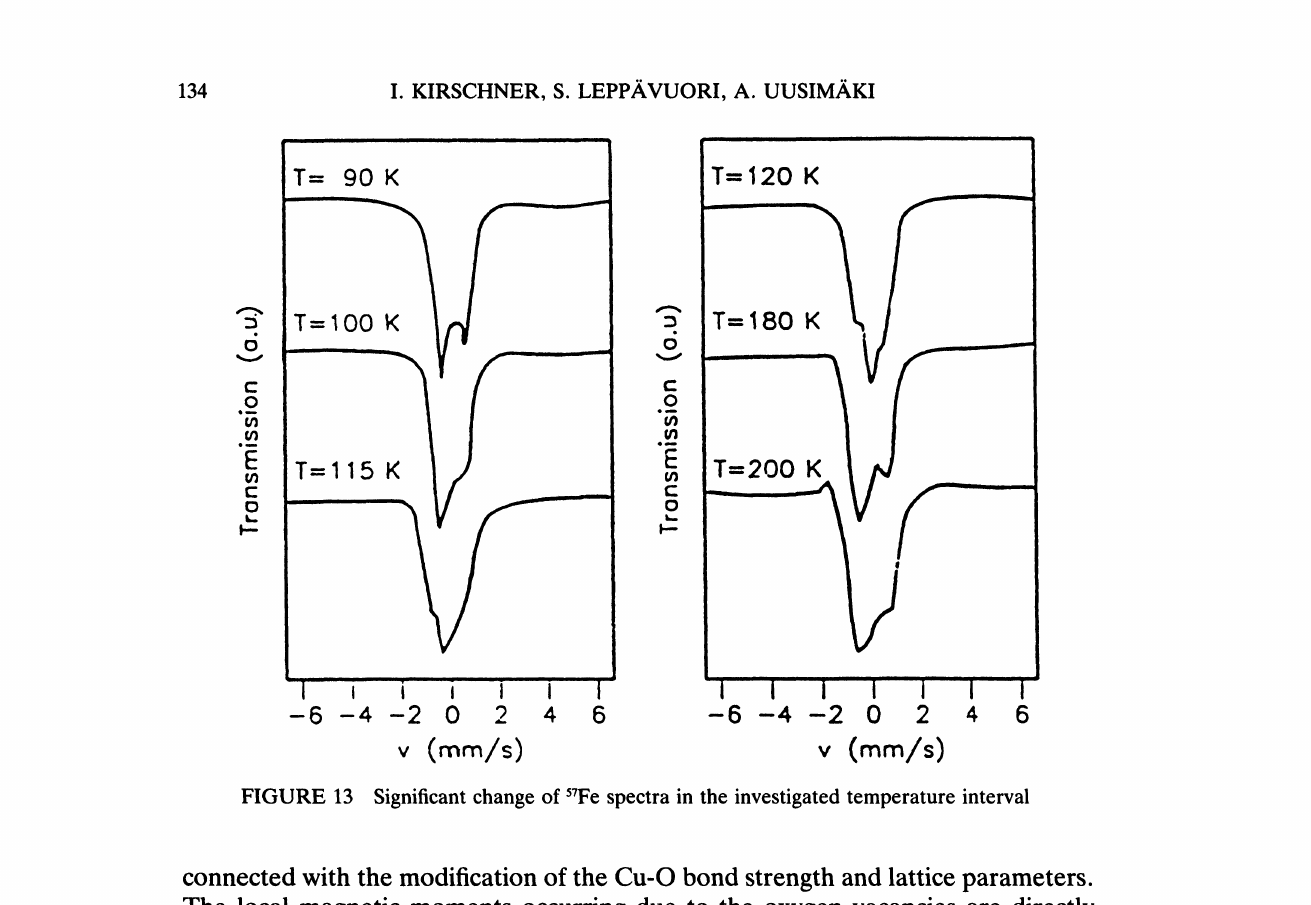
FIGURE 13 Significant change of 7Fe spectra in the investigated temperature interval connected with the modification of the Cu-O bond strength and lattice